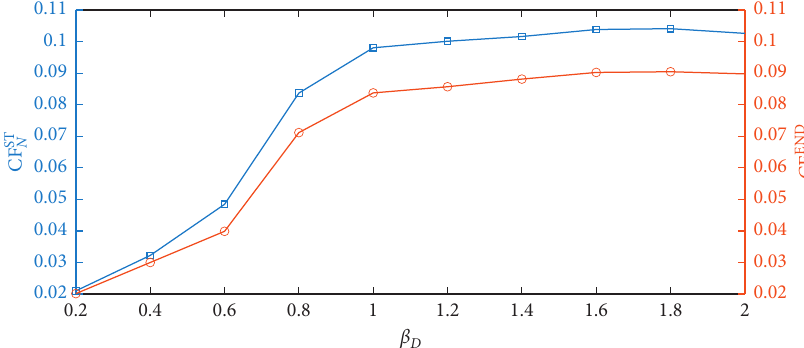
Figure 8: Effects of activity duration on end date change risk.